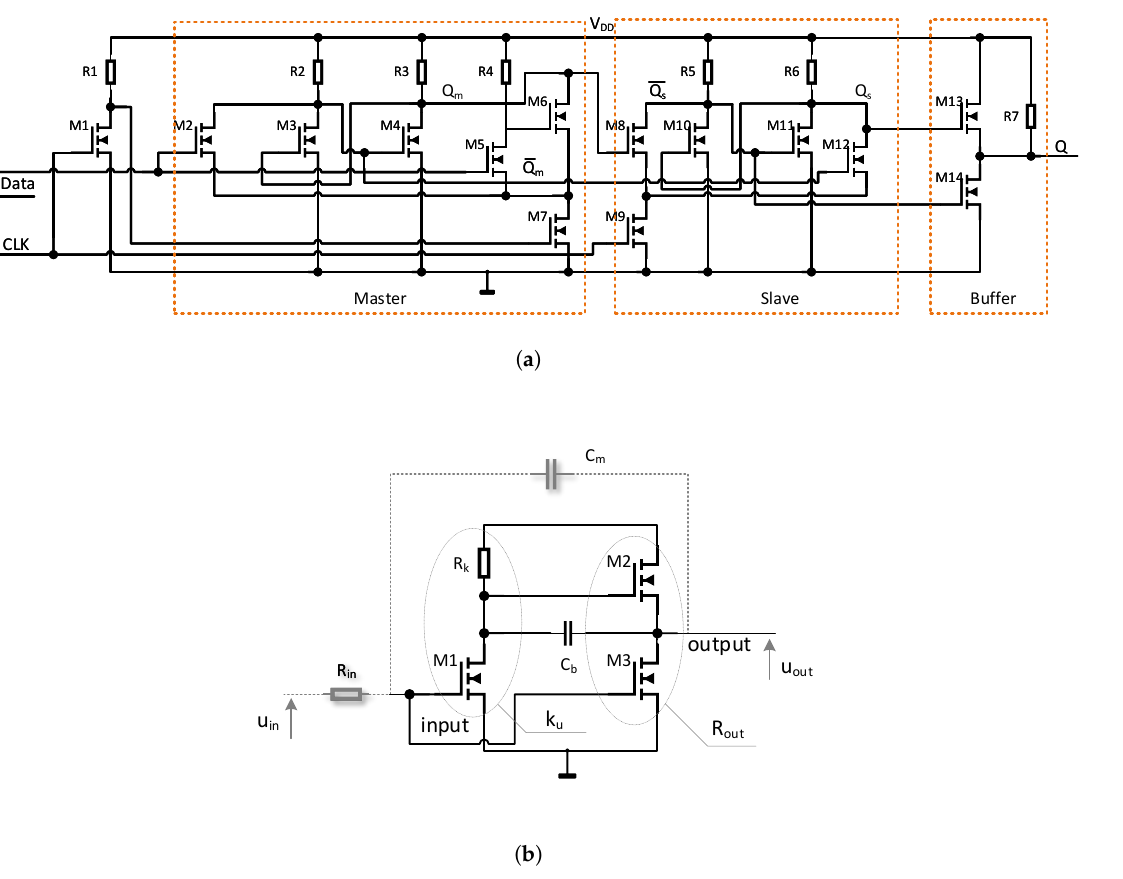
Figure 7. Internal schematics of sensor subcircuits: ( a ) schematic diagram of the D flip-flop used as a frequency mixer and ( b ) schematic diagram of the inverters used in the ring